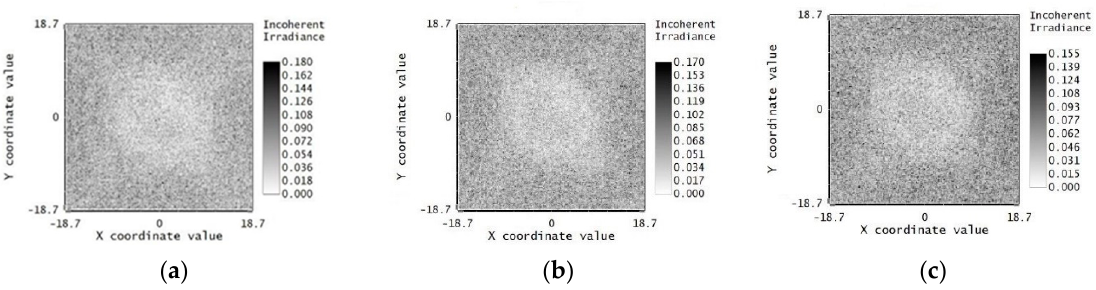
Figure 7. The simulation result of the light distribution. The unit here is W/m 2 , and the total energy emitted by each LED is 1 W. ( a – c ) Denote the simulation result if we only consider red, green, or blue LEDs, respectively.